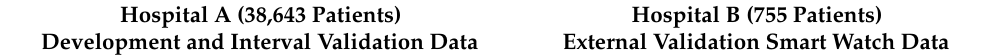
Table 1. Baseline characteristics